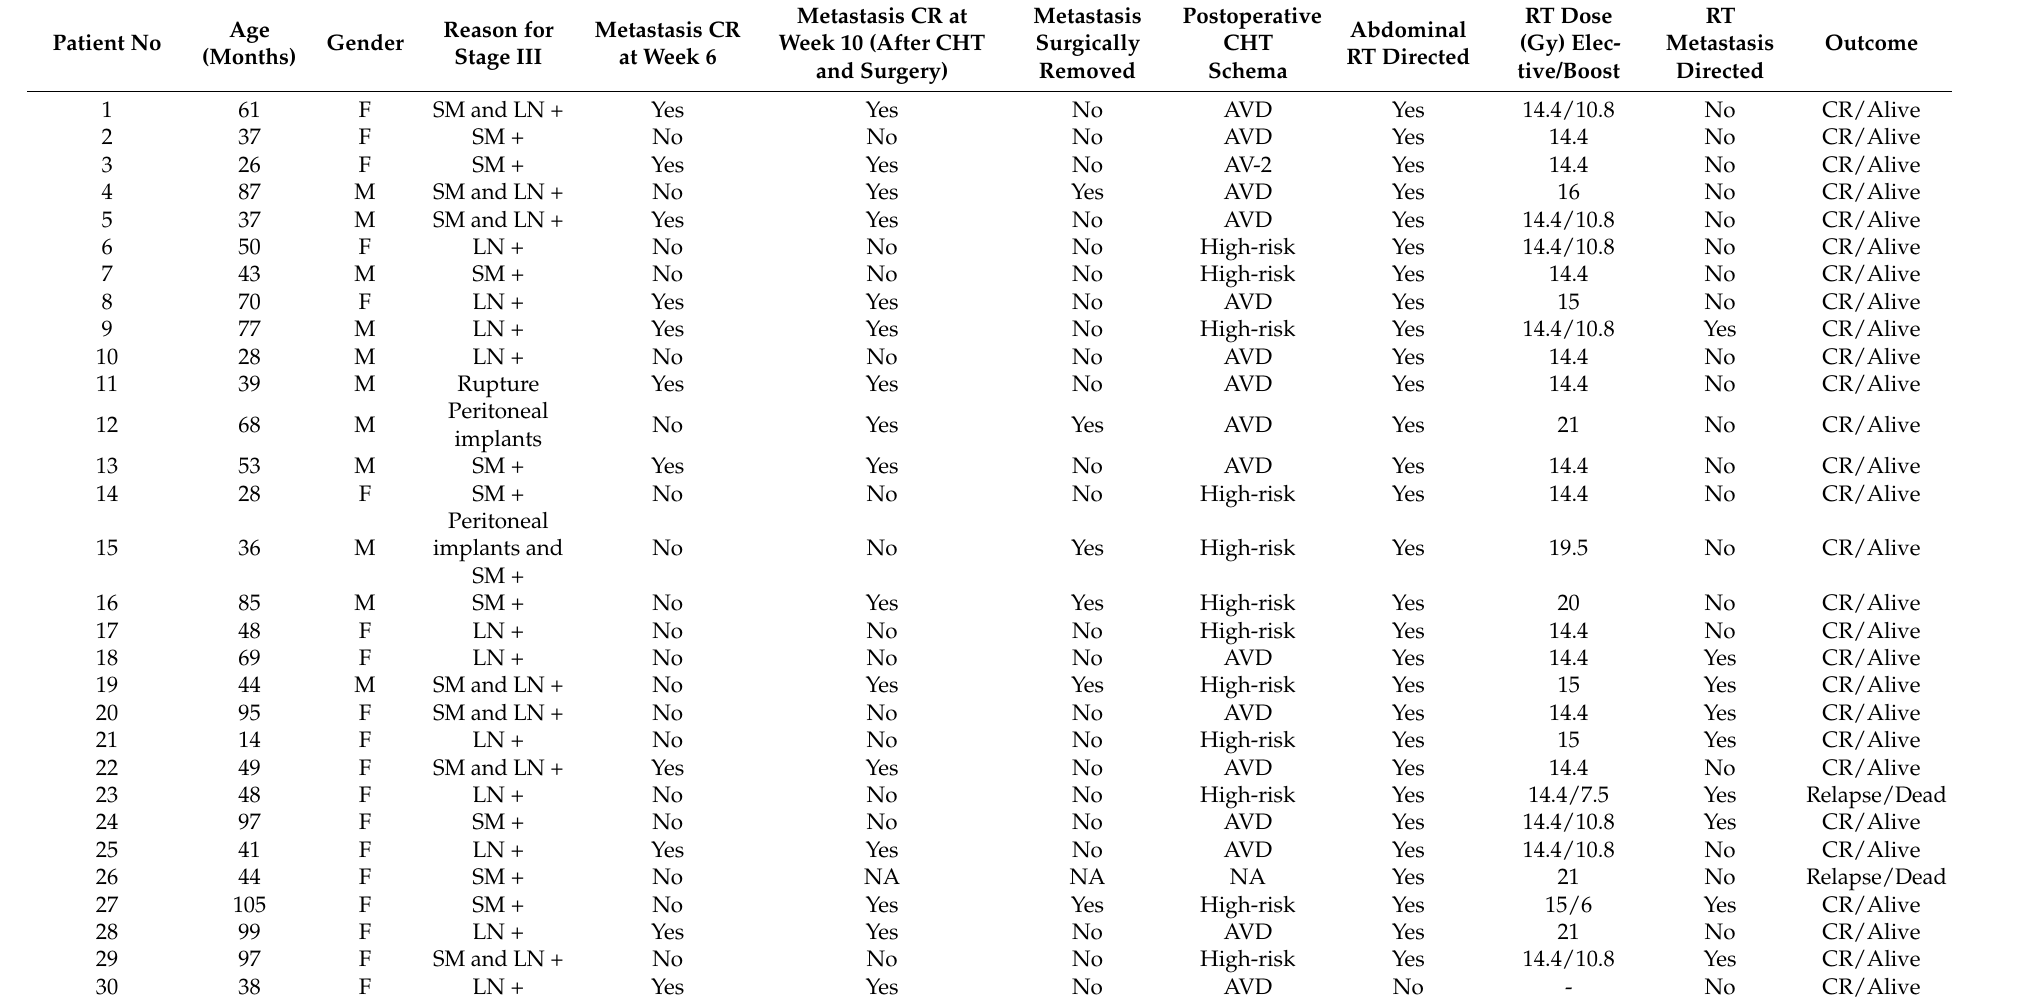
Table 2. Patient and treatment